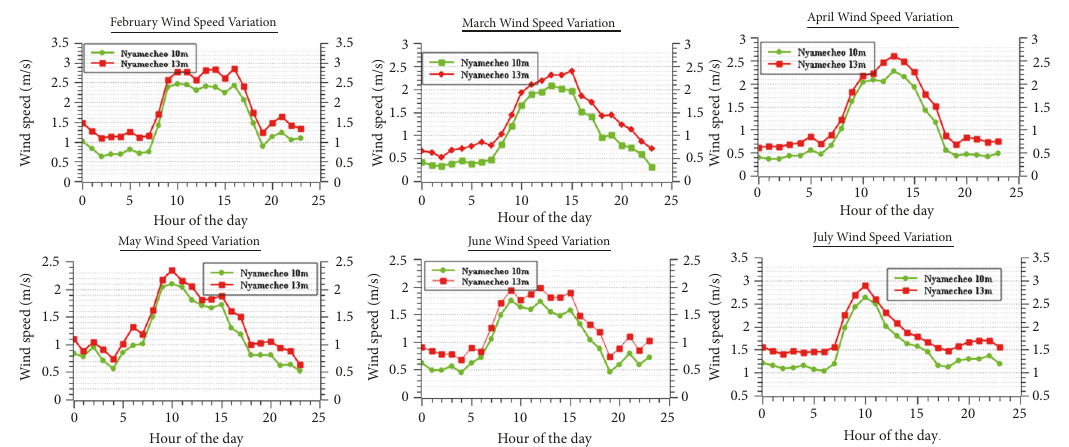
Figure 7: Nyamecheo site diurnal variation of wind speeds for months of February to July.